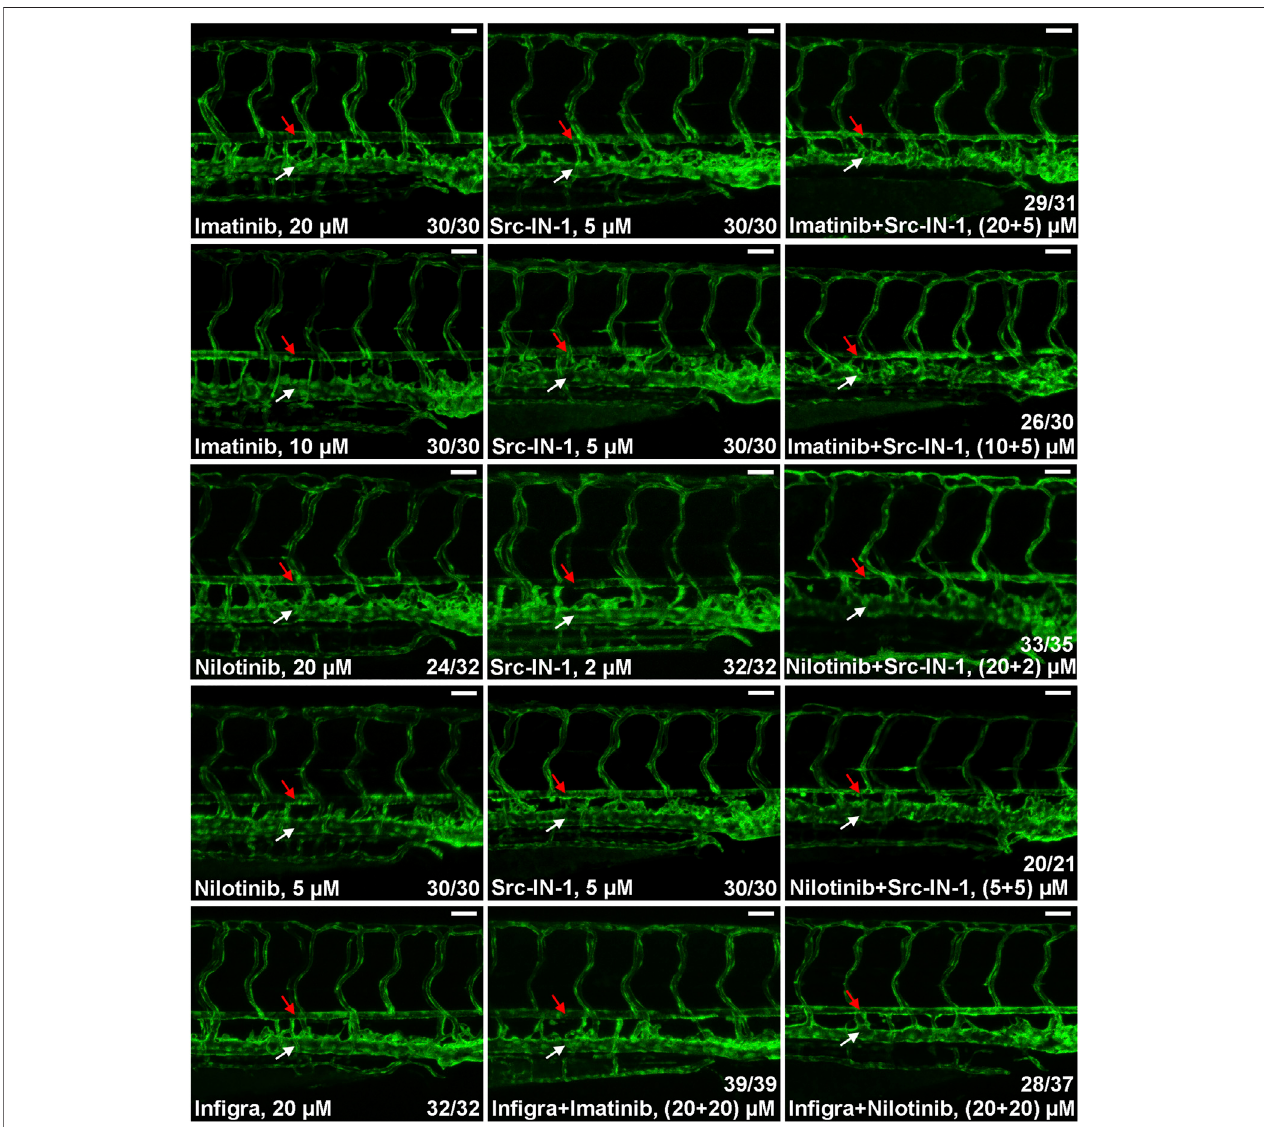
FIGURE2| SRCinhibitioncontributestostenosisofdorsalaorta.Embryosweretreatedwiththeindicateddrugsordrugcombinationsandanalyzedasdescribed in Figure 1B . Src-IN-1 is a SRC/LCK inhibitor and in fi gratinib (In fi gra) is a FGFR inhibitor. Combinatory treatment of Src-IN-1 but not in fi gratinib with imatinib or nilotinib effectively induces stenosis of dorsal aorta (red arrow) while these compounds alone is not suf fi cient to induce vessel defects. Assays were repeated twice and the list numbers are the sum of two experiments. Scale bar: 50 µm.